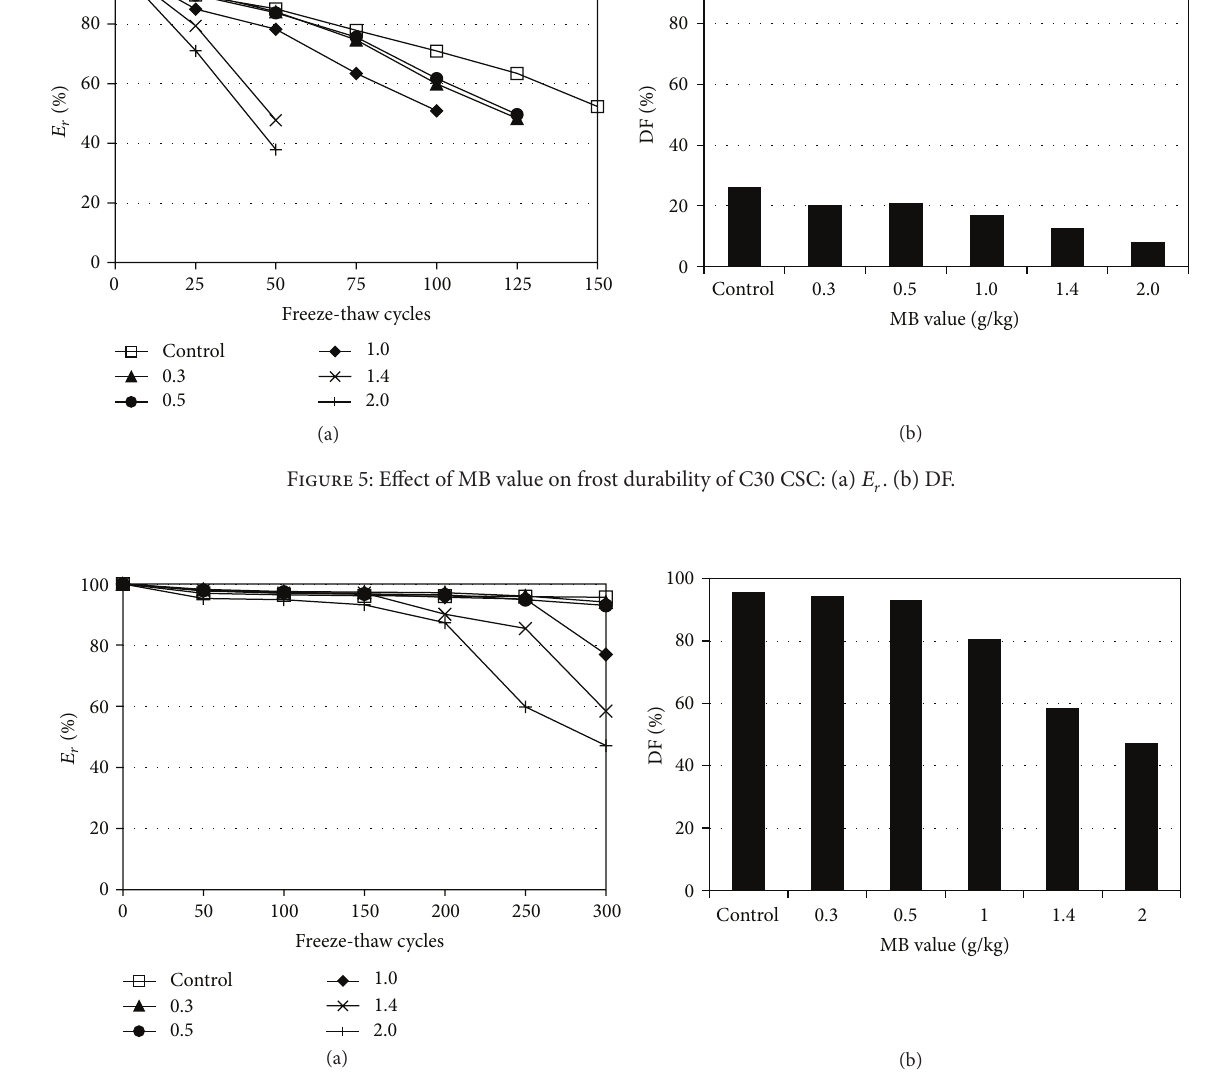
Figure 6: Effect of MB value on frost durability of C60 CSC: (a) 𝐸 𝑟 . (b)